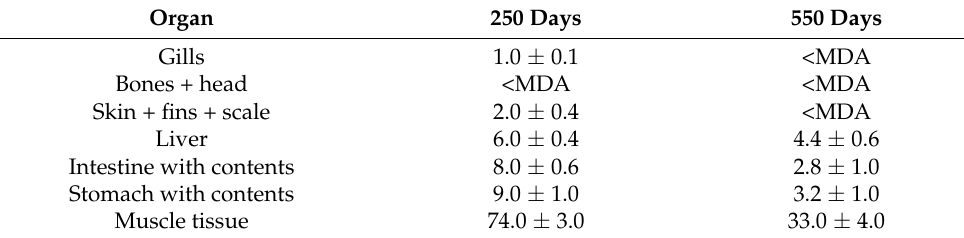
Table 6. Determination of the half-life period of tritium from the model fish ( n = 3, p = 0.95).